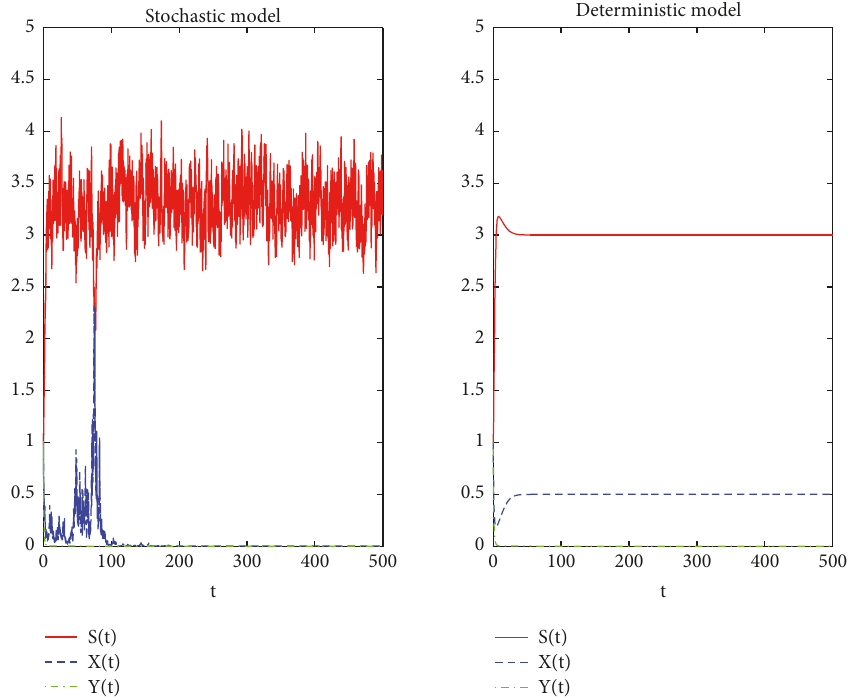
Figure4: Numerical simulationof thesolutionof system(2)and itscorresponding deterministicsystem (1)with 𝜎 1 = 0.1, 𝜎 2 = 0.6, 𝜎 3 = 0.3 , with initial value 𝑆(0) = 1, 𝑋(0) = 1, 𝑌(0) = 1 .